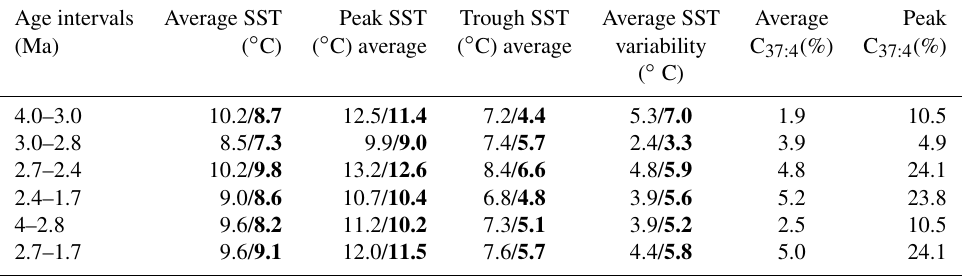
Table 1. Average SST ( ◦ C) and %C 37 : 4 during key climatic intervals at 4.0–3.0, 3.0–2.8, 2.7–2.4, and 2.4–1.7Ma. Average SST ( ◦ C) is the average of all the data points of the time interval. The peak SST ( ◦ C) average is the average of the highest data points of each interval selected (Fig. 2). The trough SST ( ◦ C) average is the average of the lowest data points of each interval (Fig. 5.2), and the average SST ( ◦ C) variability is the difference between the average SST peak and the average SST trough. In black: data calculated from U K (cid:48) (Müller et al., bold: data from U K 37